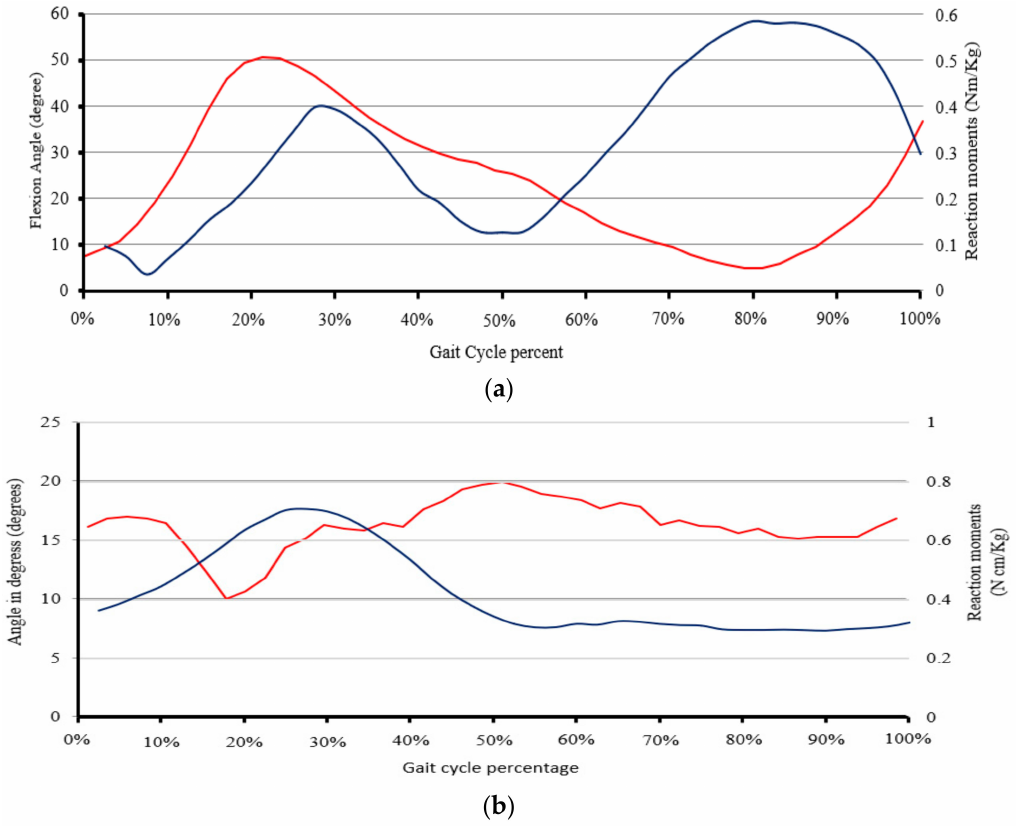
Figure 16. Resulting moments in a gait cycle during the support phase. ( A ) On the knee joint. ( B ) On the ankle joint.